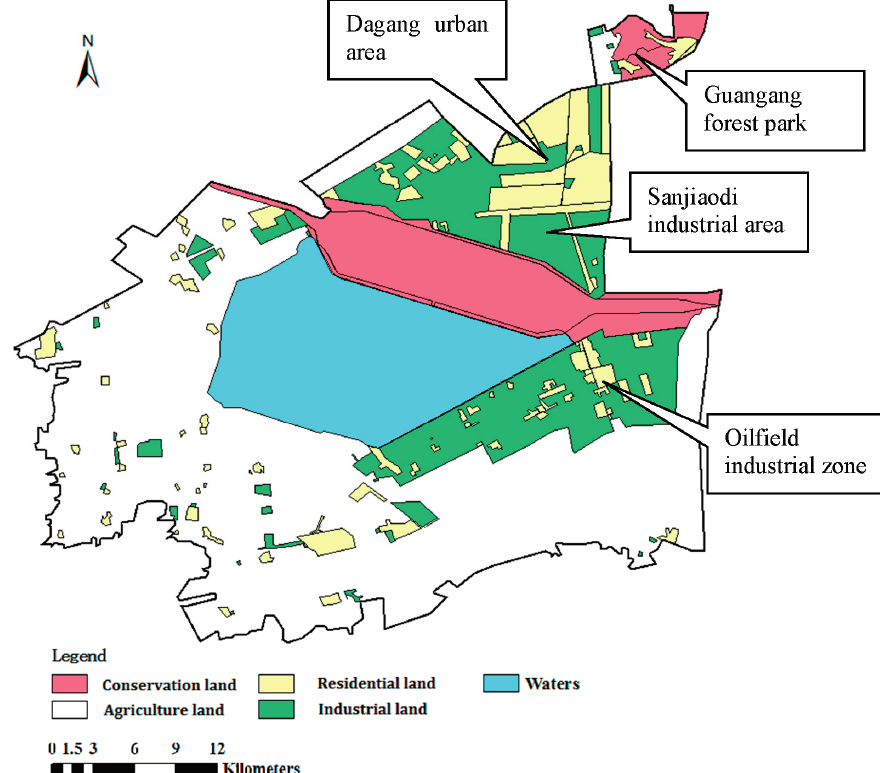
Figure 5. Land use of study